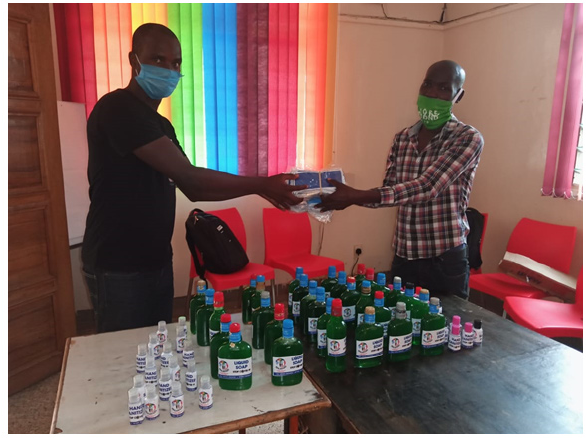
Figure 5. MAAYGO distributing hand sanitizers, face masks, and liquid soap to a partner organization.